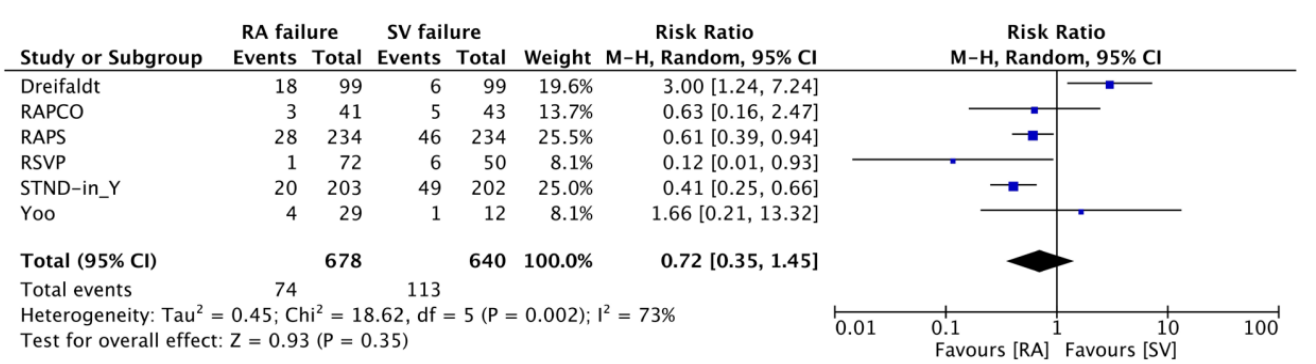
Fig. 1 – Forest plot of comparison: saphenous vein (SV) vs. radial artery (RA) patency. Data pooling was based on six randomized controlled trials with protocol-driven angiography comparing SV and RA patency. No significant difference in risk of graft failure was observed between SV and RA grafts. CI=confidence interval; M-H=Mantel-Haenszel. (From Kopjar et al. [17]